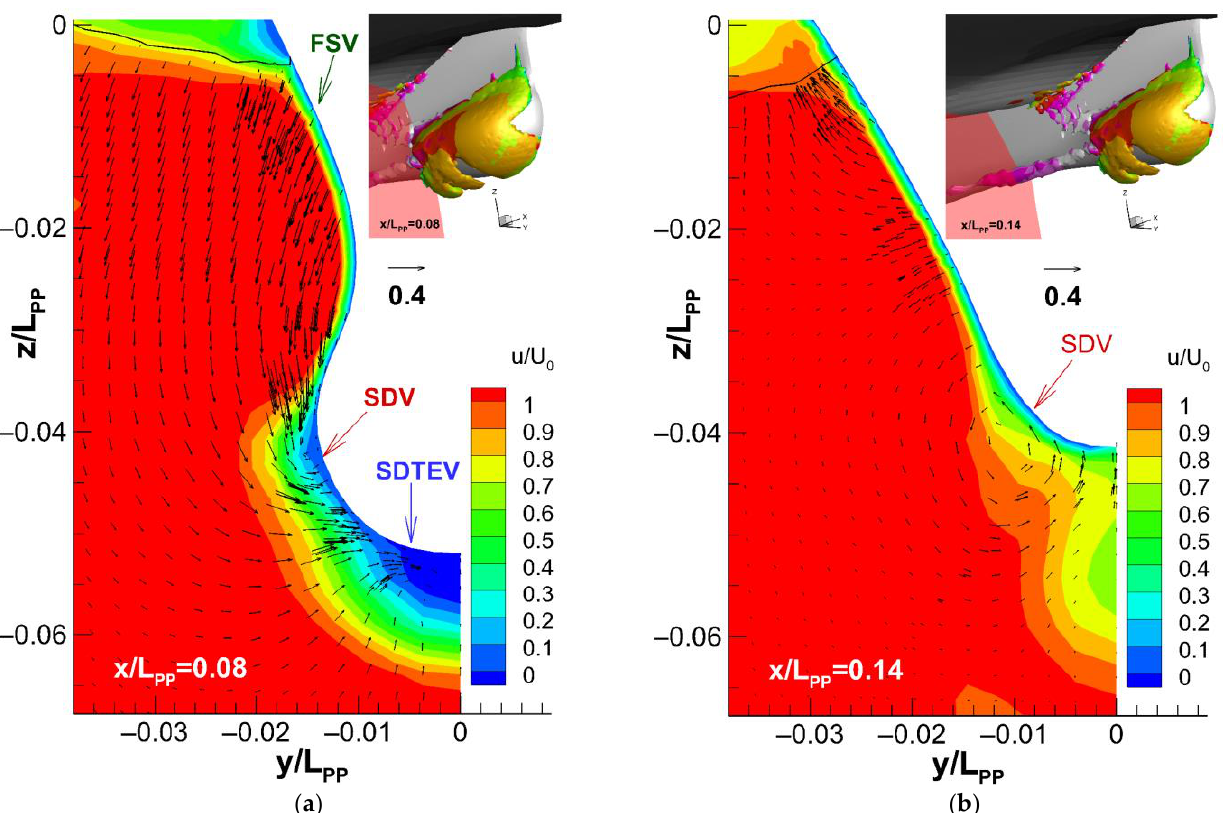
Figure 16. Axial velocity ( u/U 0 ) distribution and vector field ( v/U 0 , w/U 0 ) around F0 sonar dome on: ( a ) x/L pp = 0.08 plane; ( b ) x/L pp = 0.14 plane. The solid block line around z/L PP = 0 is the free surface.